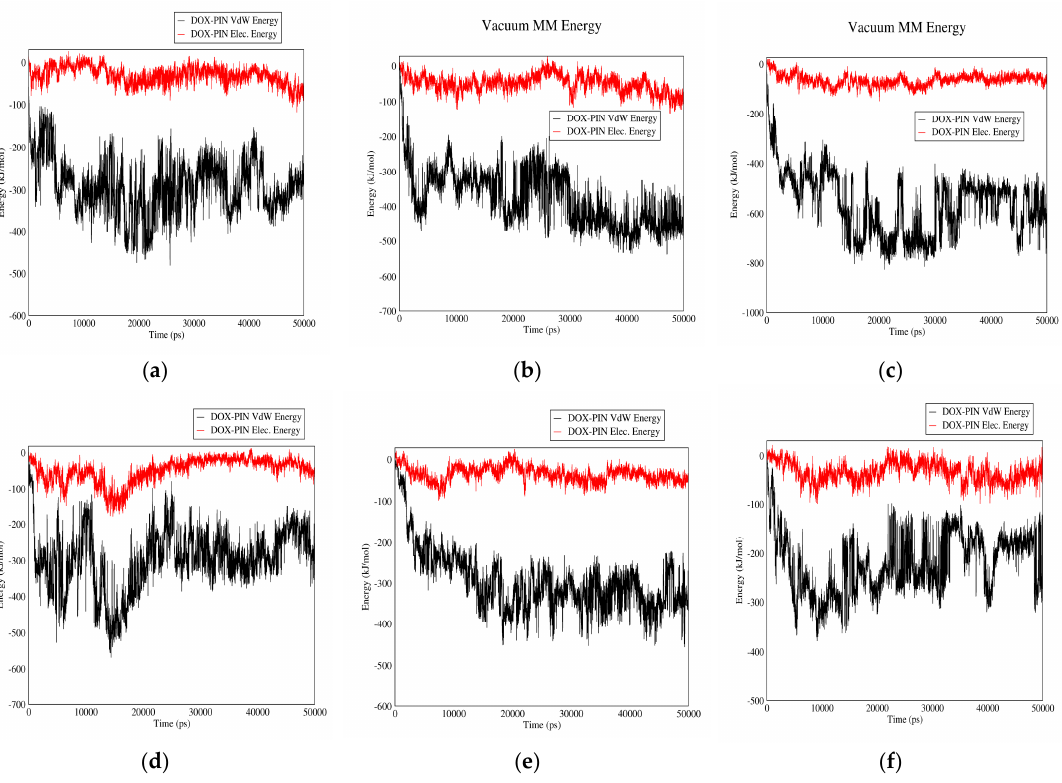
Figure 7. Electrostatic and Van der Waals energies of DOX–PIN interaction versus time in neutral and acidic pH for different carriers: ( a ) CNT in neutral pH; ( b ) fullerene in neutral pH; ( c ) GO in neutral pH; ( d ) CNT in acidic pH; ( e ) fullerene in acidic pH; ( f ) GO in acidic pH.